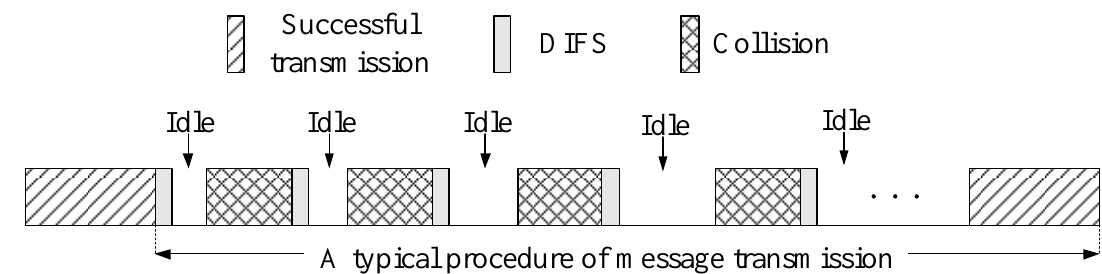
Figure 2. A typical procedure of message